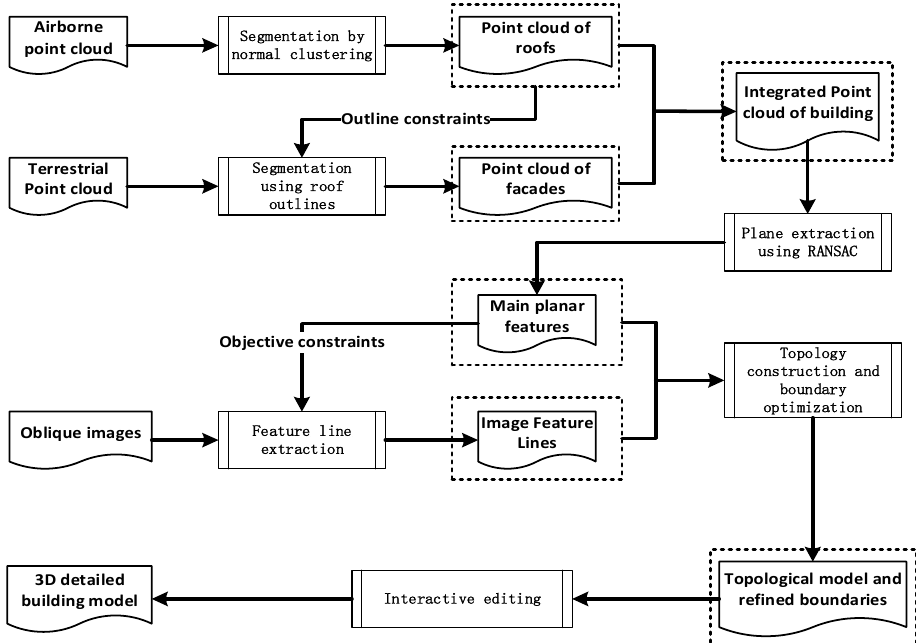
Figure 1. Flowchart of our method for reconstructing LoD3 building model.